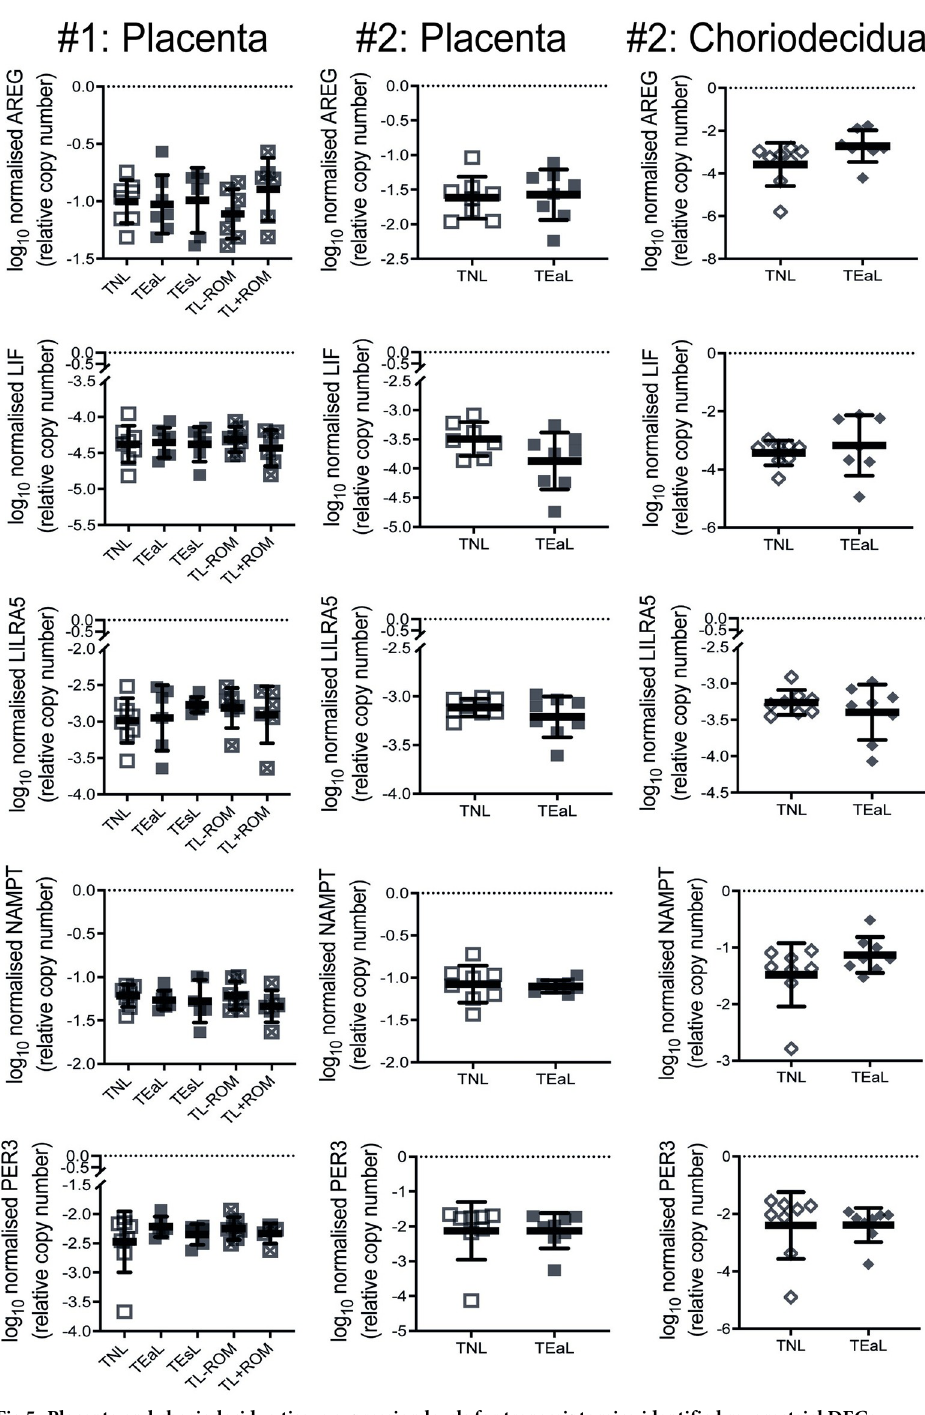
Fig 5. Placenta and choriodecidua tissue expression levels for transcriptomics-identified myometrial DEGs common to four labour classifications. Log 10 transformed qPCR data (mean with standard deviation) for mRNA expression levels in placenta and choriodecidua biopsies of genes identified from myometrium RNA-seq data (Fig 2) to be differentially expressed (DEGs) for four classifications of labour, when compared to the non-labouring state (TNL), in biopsies from the RNA-seq (‘#1’; n = 5–8) and second (‘#2’; n = 7–8) cohorts of term gestation singleton pregnant women. For cervical dilatation, labour was classified as early ( � 3 cm; TEaL) or established ( > 3 cm; TEsL) at time of Caesarean section. These TEaL and TEsL samples were alternatively classified by fetal membrane rupture (ROM) status, whereby either ROM was absent (TL-ROM) or present (TL+ROM) for > 1 hour prior to fetal delivery, to assess